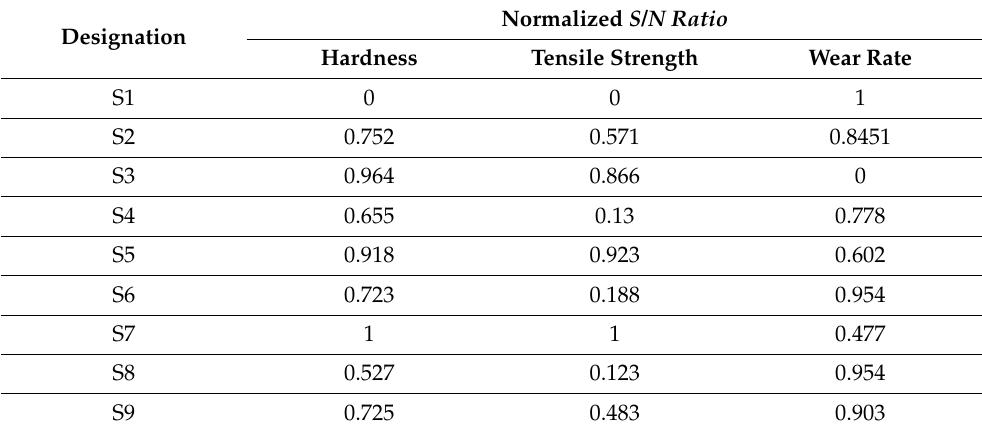
Table 11. Normalized data of the experimental results.